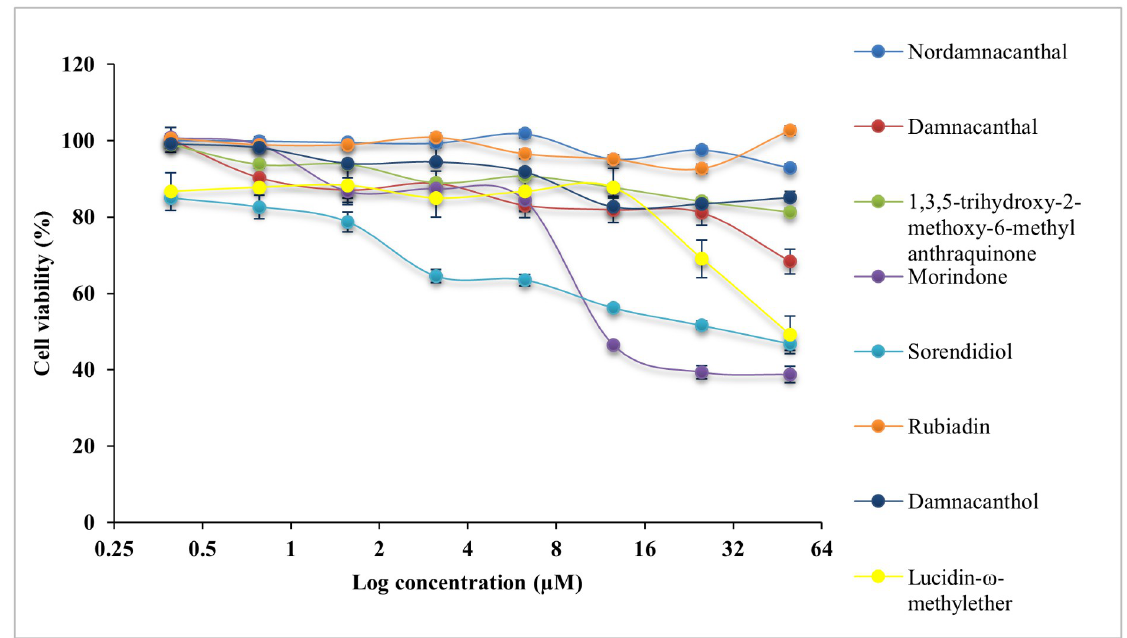
Fig 6. Cytotoxicity effect of anthraquinone compounds 1–8 on the cell viability of HT29 cells. Data was shown as mean ± SD from three independent experiments.